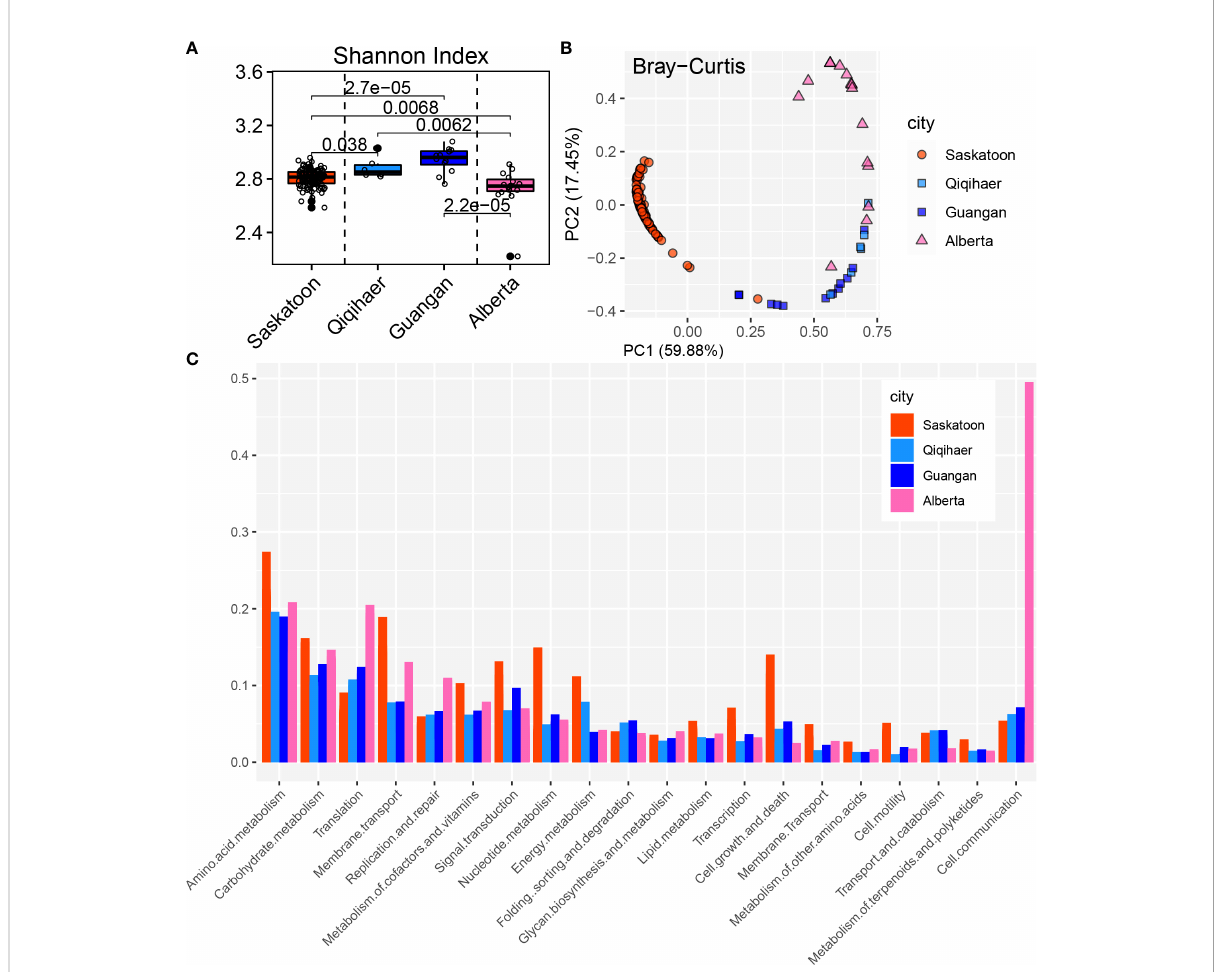
FIGURE 5 Functional analysis of bovine respiratory microbiome. (A) Shannon index of Kyoto Encyclopedia of Genes and Genomes (KEGG) function. (B) Principal coordinate analysis of the Bray – Curtis distance of the KEGG pathways. NPS, nasopharyngeal swab; BAL, bronchoalveolar lavage. (C) KEGG annotation at level